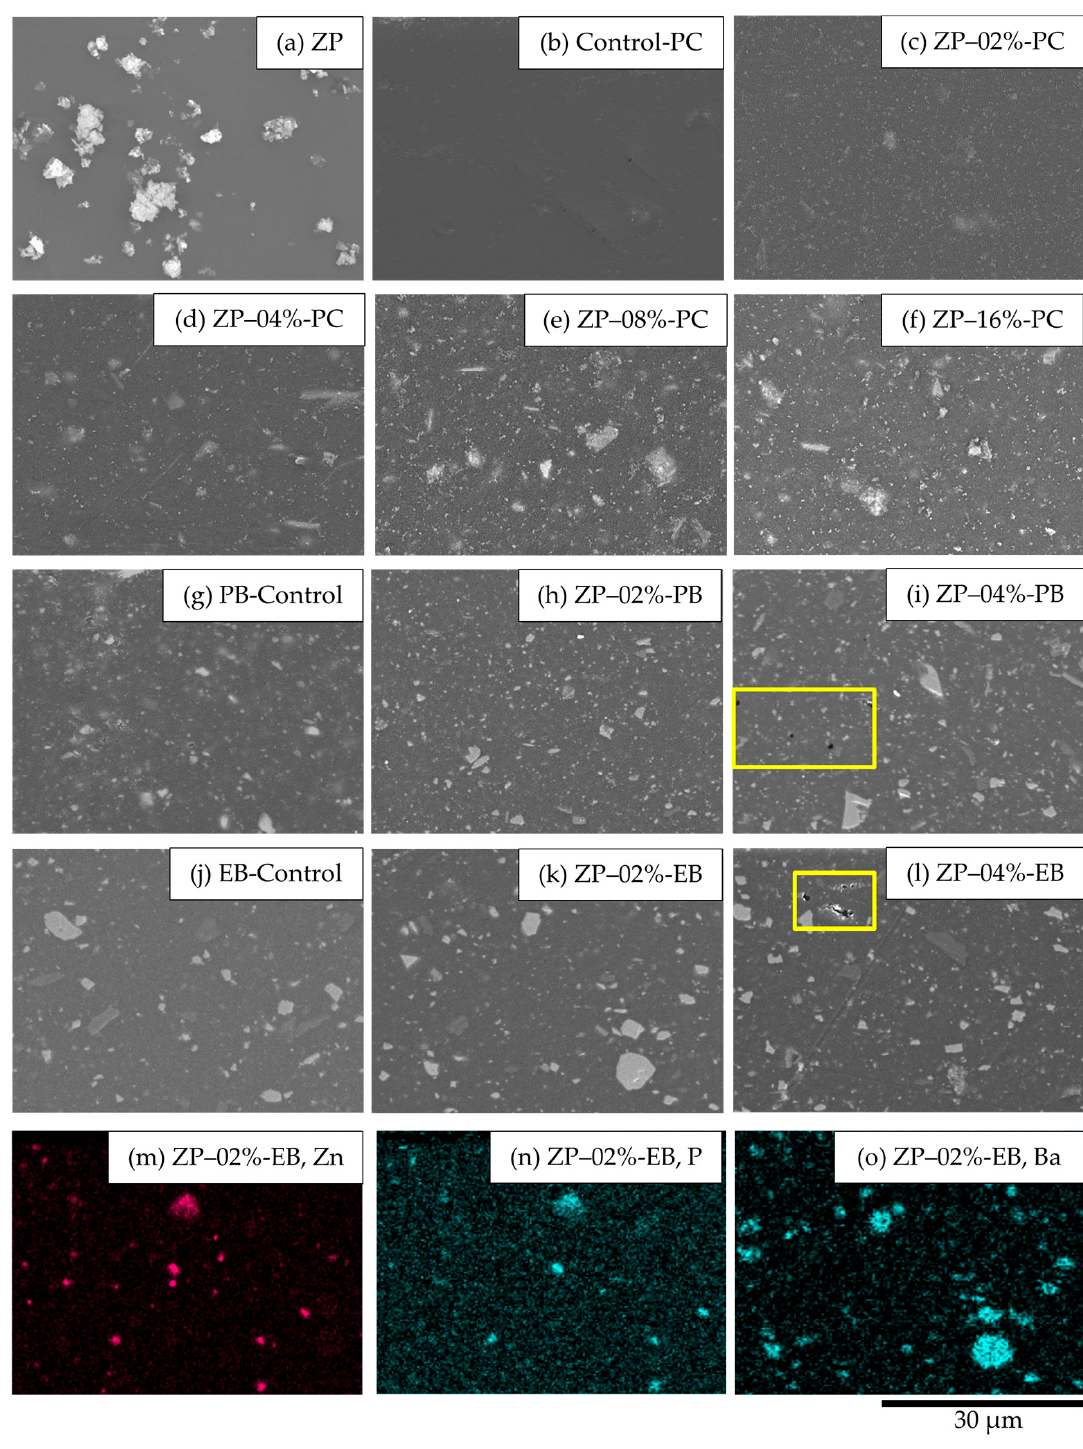
Figure 2. SEM images: ( a ) original ZP particles, cross-sections of ZP-containing coatings with differ- ent ZP contents in PC ( b ) Control-PC, ( c ) 2%, ( d ) 4%, ( e ) 8%, ( f ) 16%), PB (( g ) Control-PB, ( h ) 2%, ( i ) ZP contents in PC ( b ) Control-PC, ( c ) 2%, ( d ) 4%, ( e ) 8%, ( f ) 16%, PB (( g ) Control-PB, ( h ) 2%, ( i ) 4%), and EB (( j ) Control-EB, ( k ) 2%, ( l ) 4%); voids in highlighted areas; EDX maps of the coating prepared by ZP–02%-EB ( m ) Zn, ( n ) P and ( o )